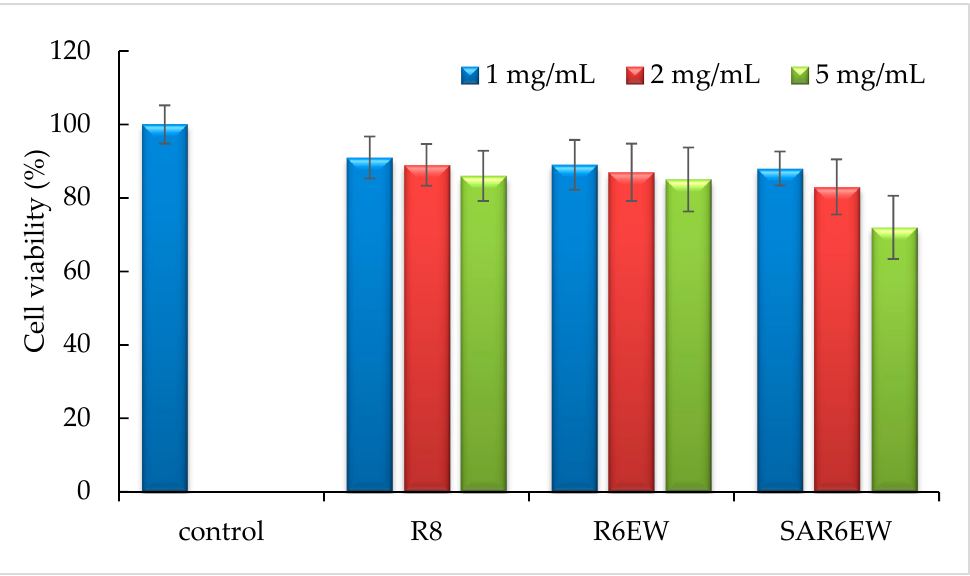
Figure 8. Cytotoxicity of R8 derivatives on Caco-2 cells at 1, 2, and 5 mg/mL (mean ± SD, n = 3).